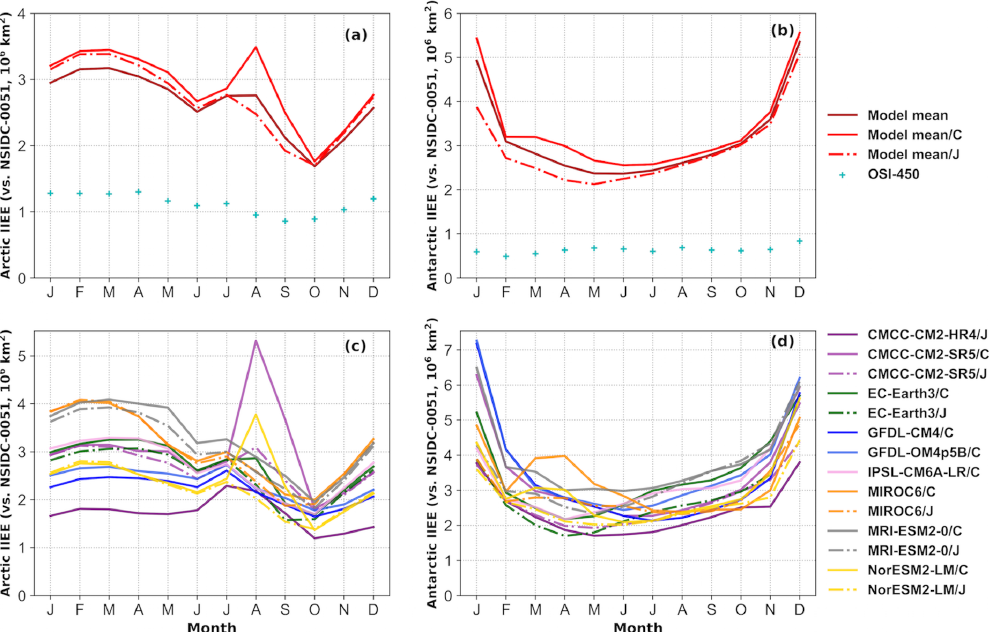
Figure 6. The 1980–2007 mean seasonal cycle of the integrated ice-edge error (IIEE; vs. NSIDC-0051, 10 6 km 2 ) from 14-model mean (solid brick red), five-model mean under OMIP1 and OMIP2 protocols (red solid and dash-dotted red), and OSI-450 (cyan + ) in the (a) Arctic and (b) Antarctic. The five-model mean is from CMCC-CM2-SR5, EC-Earth3, MIROC6, MRI-ESM2-0, and NorESM2-LM. The mean seasonal cycle from 14 model outputs under OMIP1 (/C) and OMIP2 (/J) protocols are shown in panels (c) and (d) , and the model outputs under OMIP2 protocol from the five models are in dash-dotted